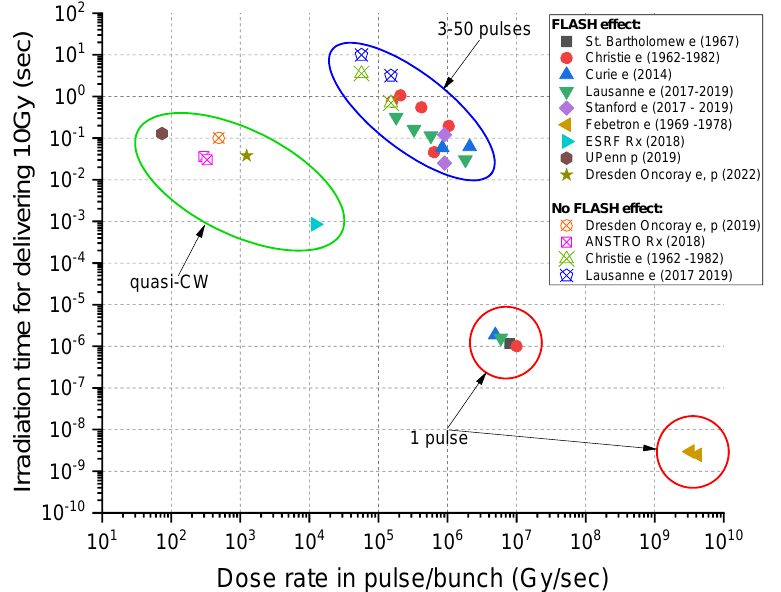
Figure 1. Summary of preclinical studies at different accelerator facilities with different radiation types (right panel). Note the irradiation time for delivering 10 Gy on the vertical axis and the IDR of linac pulses or CW bunches on the horizontal axis. The FLASH effect has been observed for a wide IDR range of repeated linac pulses and different types of quasi-CW bunch delivery with iso-cyclotrons and synchrotron radiation light sources. FLASH effects were also seen with single electron pulses with IDR in the range of 10 6 –10 7 Gy/s and 10 9 –10 10 Gy/s, respectively. Modified from Montay-Gruel P et al. [15]; for references of the individual data points, see that publication. We added the data point from Karsch et al. [16] and grouped the data according to delivery method.